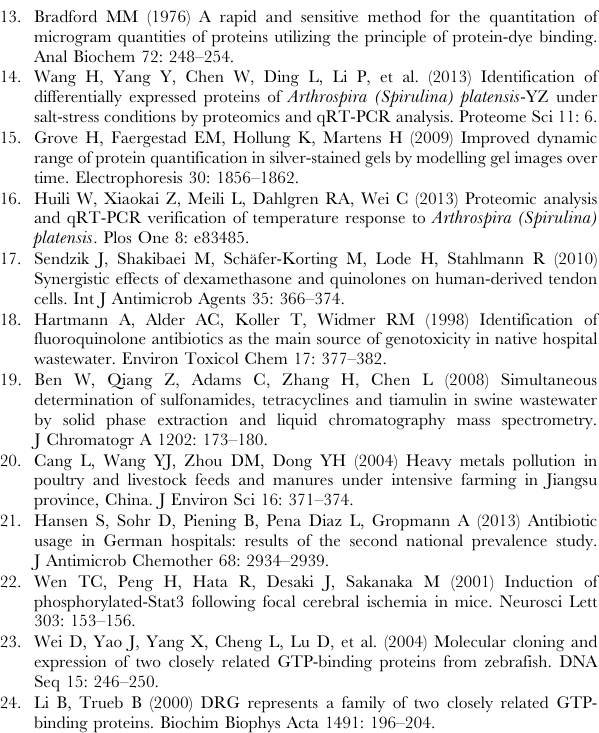
Figure S1 2-DE and the mass spectrum of protein spots in the control and 9.38 mg/L treatment. (TIF) Figure S2 The profile of total RNA in control and 9.38 mg/L DKA-exposed treatments. (TIF) Figure S3 COG functional classification of 26 positively differential expression proteins. Table S1 The primers used for amplification of target and b -actin protein